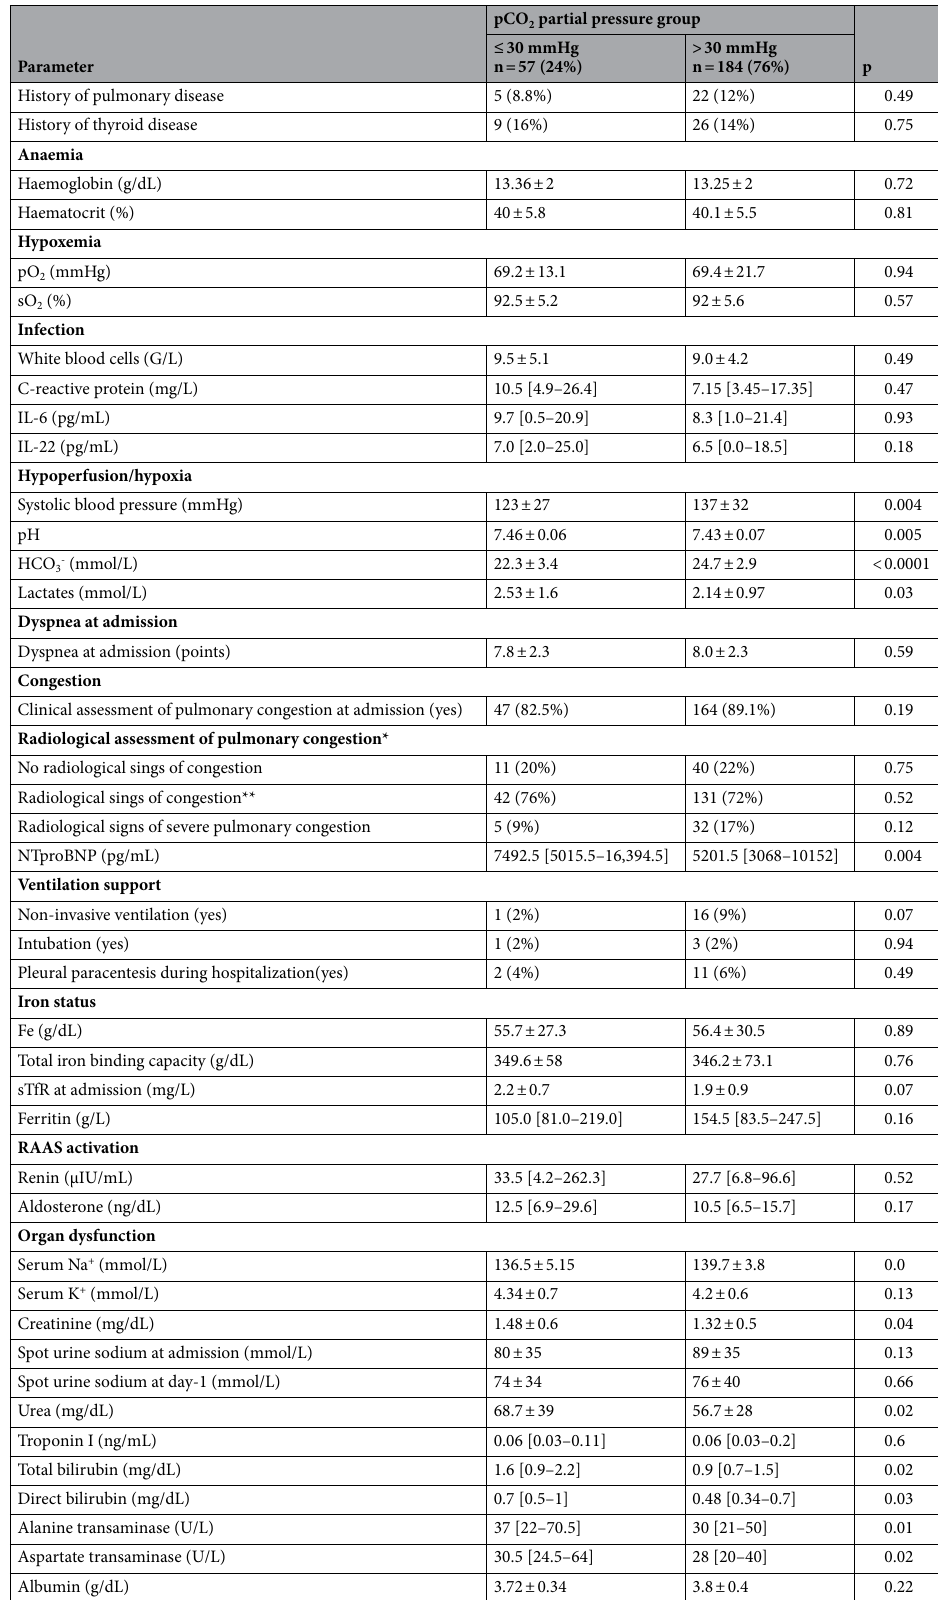
Table 2. Comparison of selected, potential triggers of hyperventilation by pCO 2 level on admission. *Data available in n = 237. **Defined as pleural effusion, any signs of congestion not classified as radiological signs of pulmonary